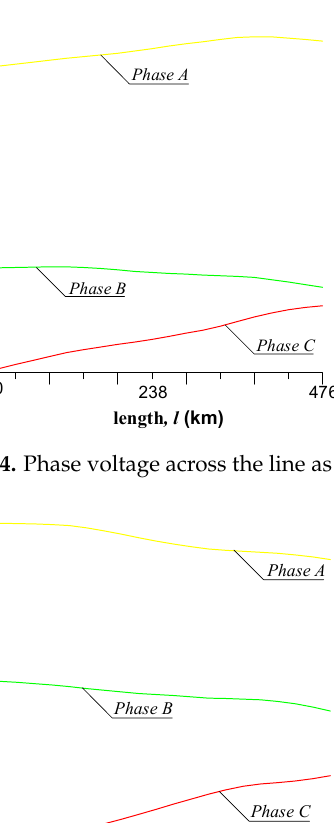
ages: e A = 615 sin( ωt ) kV, e B = 615 sin( ωt − 120°) kV, e C = 615 sin( ωt + 120°) kV. The voltage and current waveforms in the Figures are colored as follows: phase A—yellow, phase B—green, phase C—red. The phase voltage across the line as a function of distance at t = 0.005 s from the time of the voltage turn-on is depicted in Figure 4.